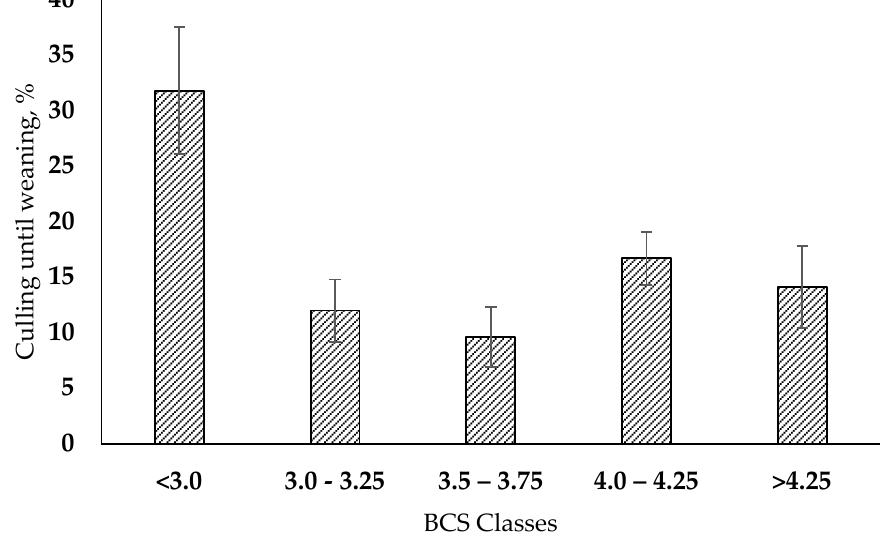
Figure 2. Effect of maternal body condition score on the culling rates until weaning of their offspring. Error bars indicate the standard error of the mean.